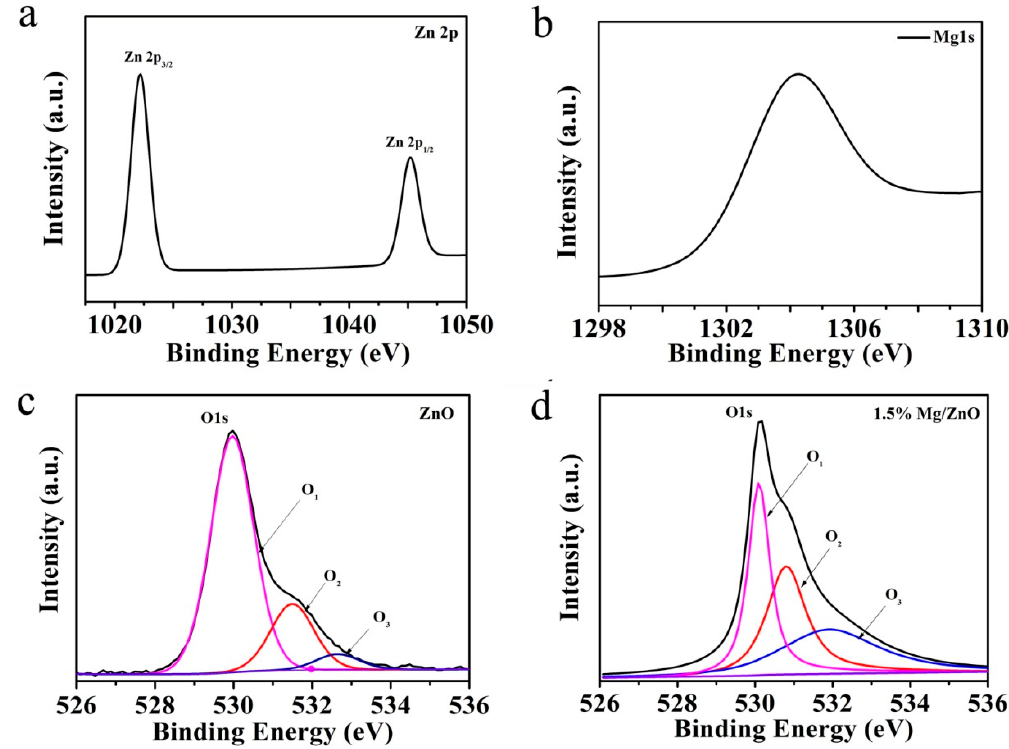
Figure 4. The XPS spectra of ( a ) Zn 2p, ( b ) Mg (1 s) of Mg-doped ZnO (1.5 mol%). The XPS spectra of O (1 s) of ( c ) undoped and ( d ) Mg-doped ZnO (1.5 mol%), respectively.